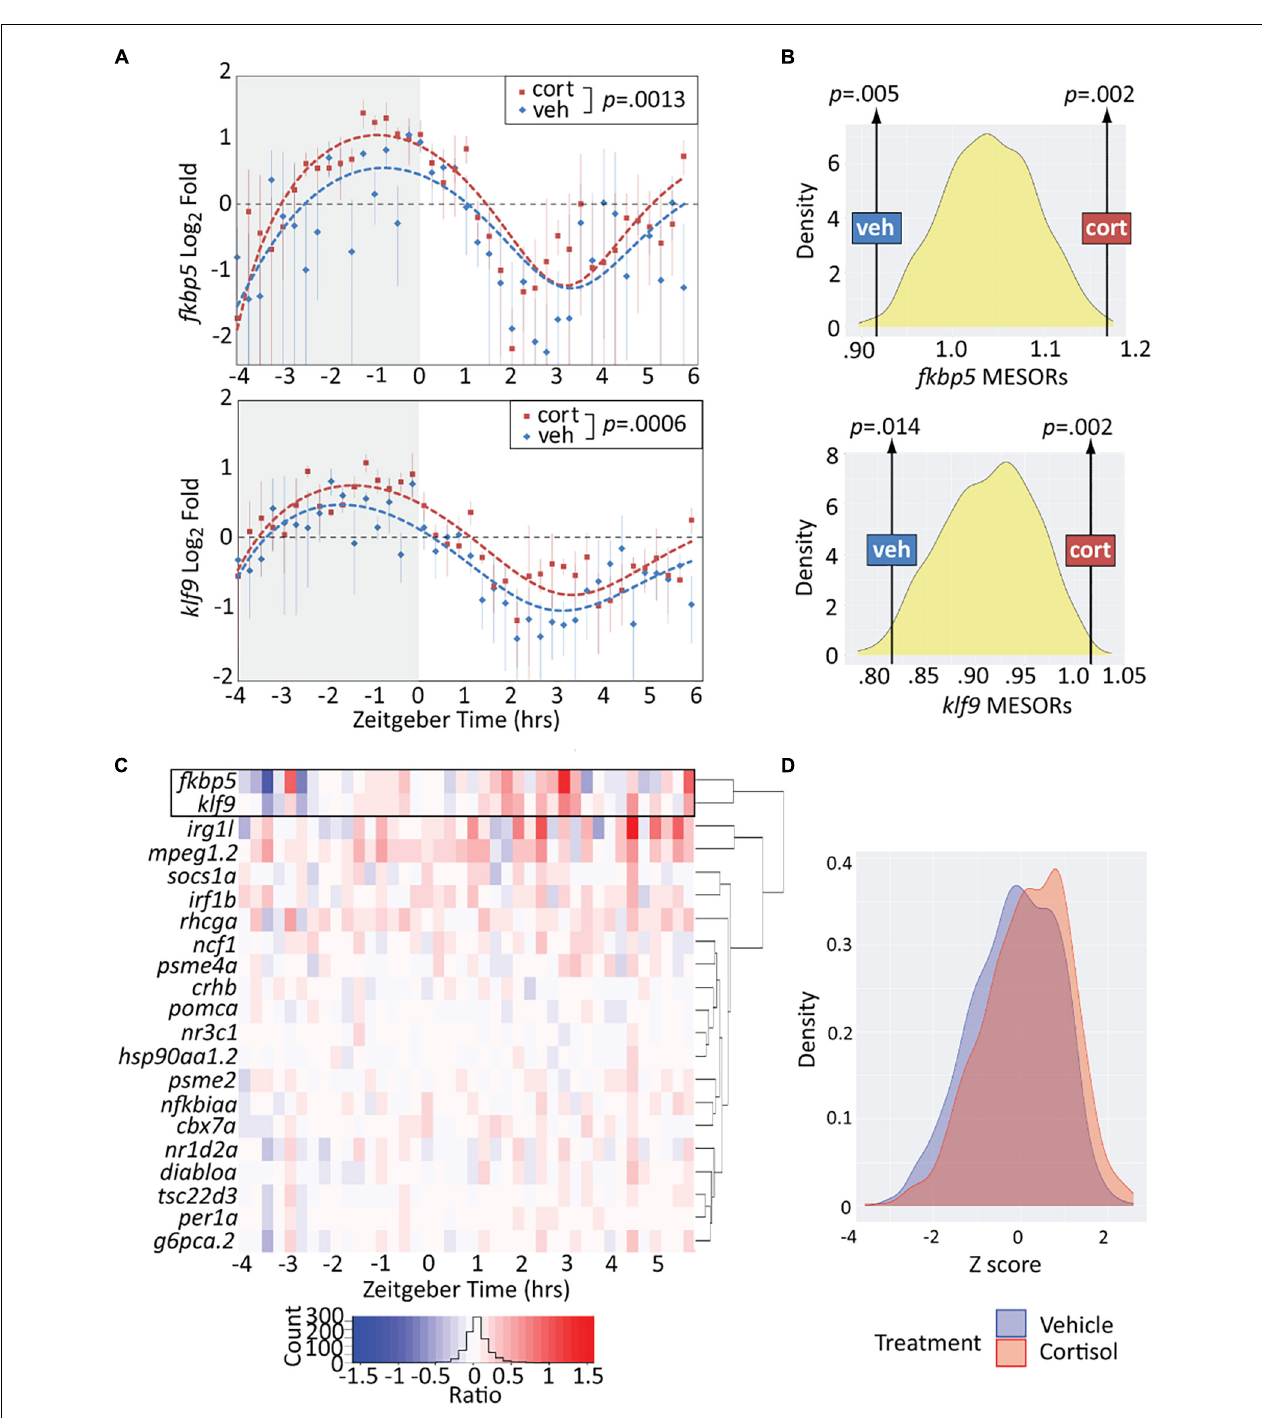
FIGURE 2 | Chronic cortisol treatment similarly upregulates klf9 and fkbp5 . (A) Sinusoid models fit to fkbp5 (top) and klf9 (bottom) qPCR relative expression data. Each data point represents the average of three biological replicates of pooled larvae (3–6 larvae per pooled sample; VEH-treated datapoints are the same as in Figure 1 ). P -values calculated using paired t -test (data paired at each timepoint). Fit of the model to the data was tested by ANOVA ( P < 0.0001 in each case, see Supplementary Figure 2 ). (B) Distributions of Midline Estimated Statistics Of Rhythmicity (MESORs, a rhythm-adjusted mean) of datasets generated by randomly selecting expression data from VEH or CORT samples at each timepoint in experiments shown in panel (A) . MESORs of VEH and CORT datasets sit at either extreme. (C) Heat map of the expression ratio in CORT/VEH samples (log2 transformed) of klf9 , fkbp5 , and other targets of glucocorticoid (GC) signaling in our Nanostring data set. (D) Density plot of Z-scored expression of all genes measured with Nanostring indicates an overall increase in expression due to chronic CORT treatment.